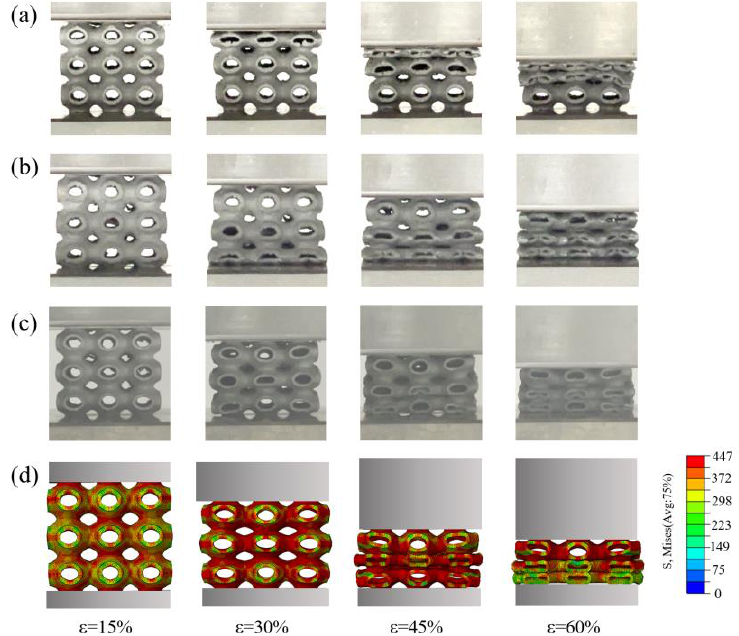
Figure 8. Deformation mode related to building direction: ( a ) The compression direction is consistent with the building direction, 𝐹⃗ = 𝐵⃗⃗ ; ( b ) the compression direction is opposite to the building direction, 𝐹⃗ = −𝐵⃗⃗ ; ( c ) the compression direction is perpendicular to the building direction, 𝐹⃗ ⊥ 𝐵⃗⃗ ; ( d ) finite element simulation deformation diagram.